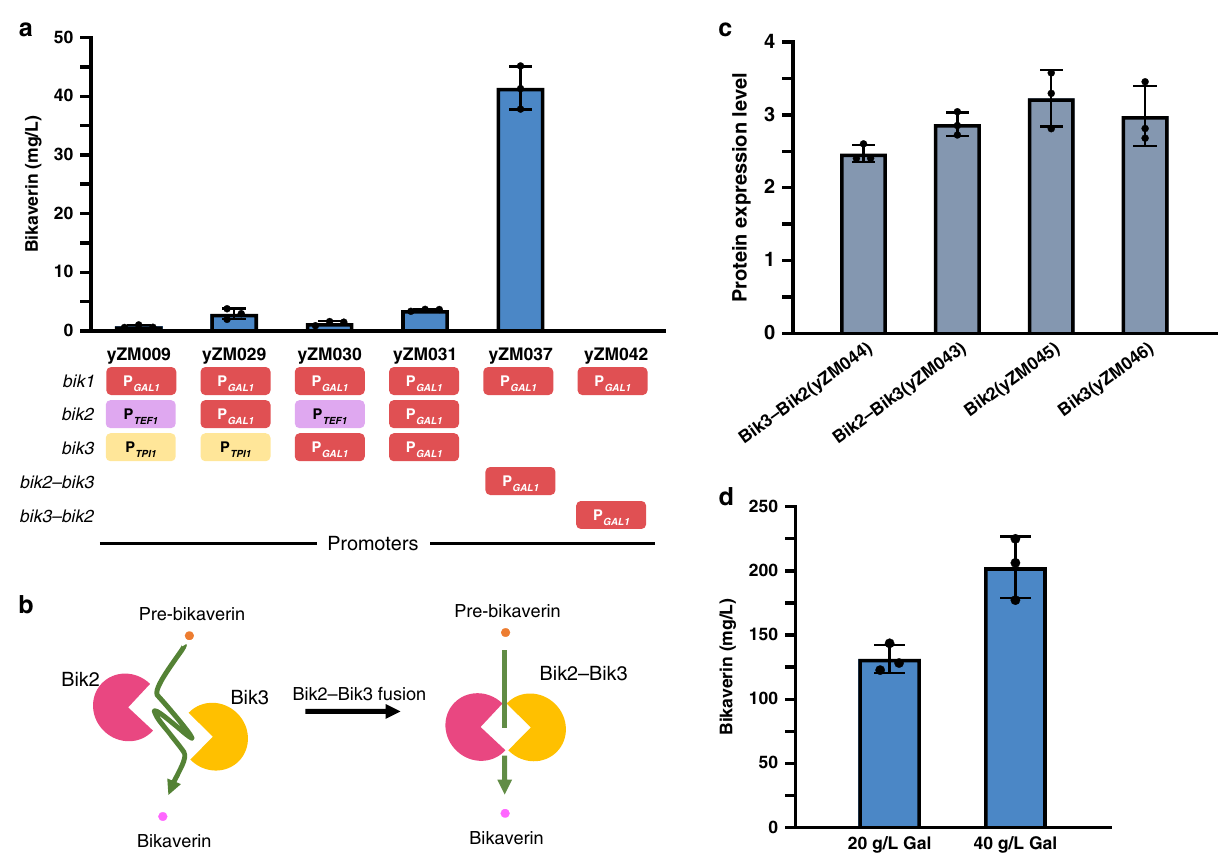
Fig. 5 Optimization to improve bikaverin titer using promoter exchange and enzyme fusion strategies. a Driving bik2 and bik3 using P GAL1 led to a modest increase (yZM031). Promoters used are shown in different color rectangles. Fusing Bik2 and Bik3 led to a dramatic increase in bikaverin titer (yZM037), 60-fold higher than the original strain (yZM009). The strain with the ‘ opposite polarity ’ fusion as Bik3 – Bik2 produced no bikaverin (yZM042). b Substrates channel model between Bik2 and Bik3. The fusion of Bik2 and Bik3 may form a short and adaptive substrate channel. c Relative protein expression levels of Bik2 – His6, Bik3 – His6, fusion proteins Bik3 – Bik2 – His6 and Bik2 – Bik3 – His6 using P GAL1 promoter by quantitative western blotting. Each protein was fused with 6×His-tag at its C-terminus. Protein expression level was measured as the intensity of target protein band divided by the intensity of the GAPDH band. d The bikaverin titer from fl ask fermentation. Strain yZM037 was cultured in YP medium supplemented with 20 or 40 g/L galactose as the carbon source. Data in a , c , d are presented as mean values ± SD from n = 3 biological replicates. Source data underlying a , c , and d are provided as a Source Data fi